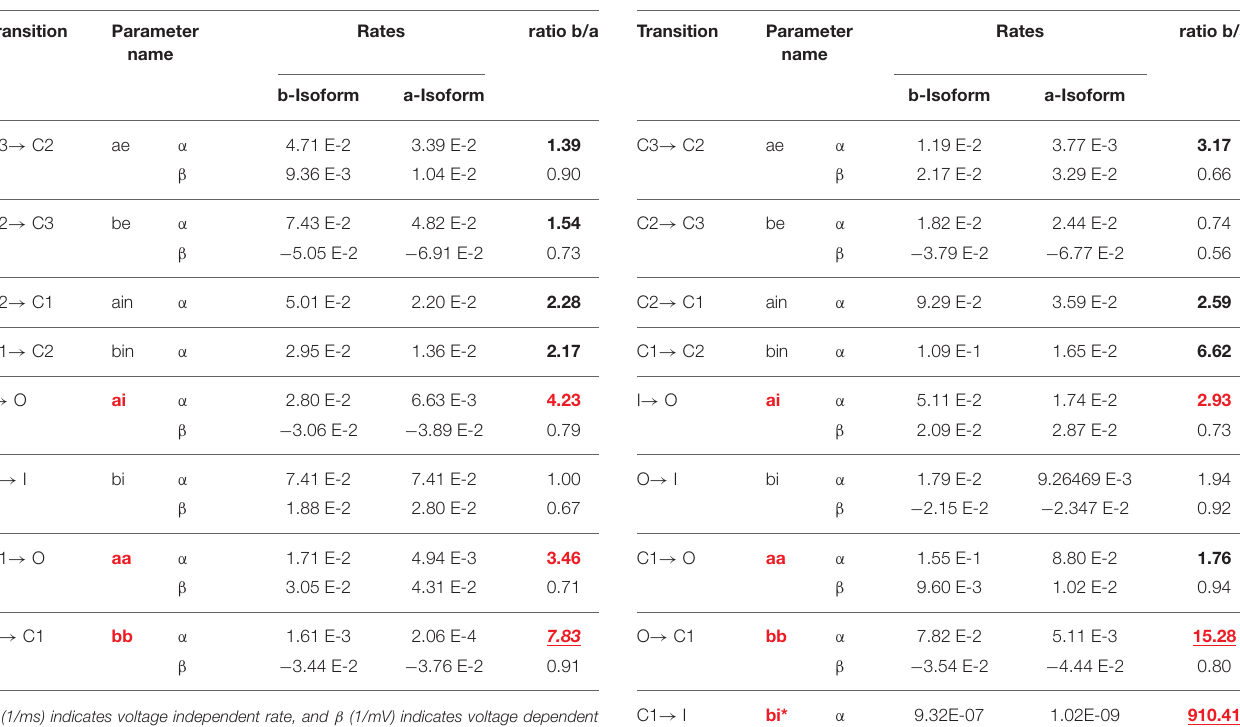
TABLE 3 | M-model 2 rate constants for transitions within hERG gating for a-isoform and